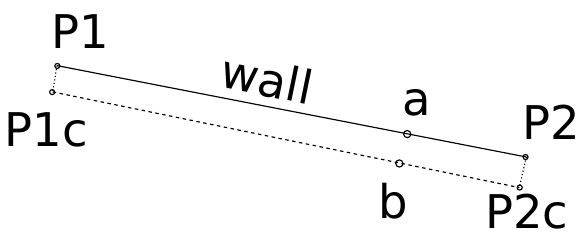
Figure 1. Visualisation of the problem discussed by